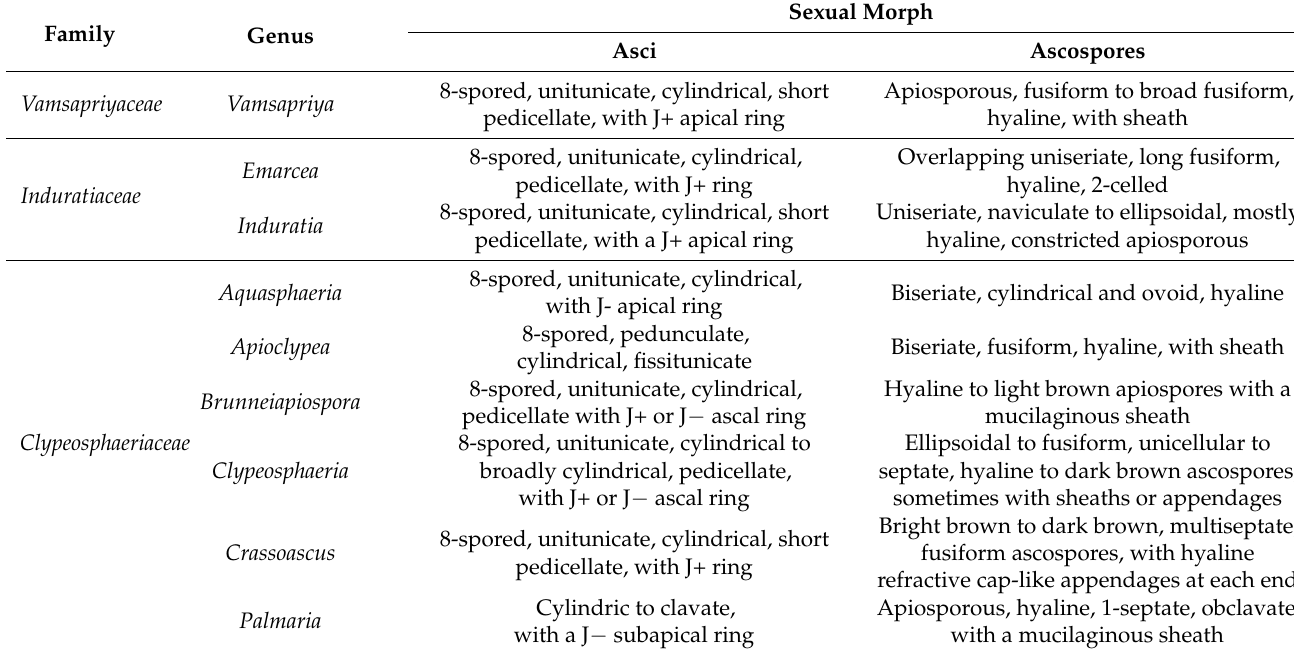
Table 6. Sexual morph comparison of the genera in Clypeosphaeriaceae , Induratiaceae and Vamsapriyaceae . Family